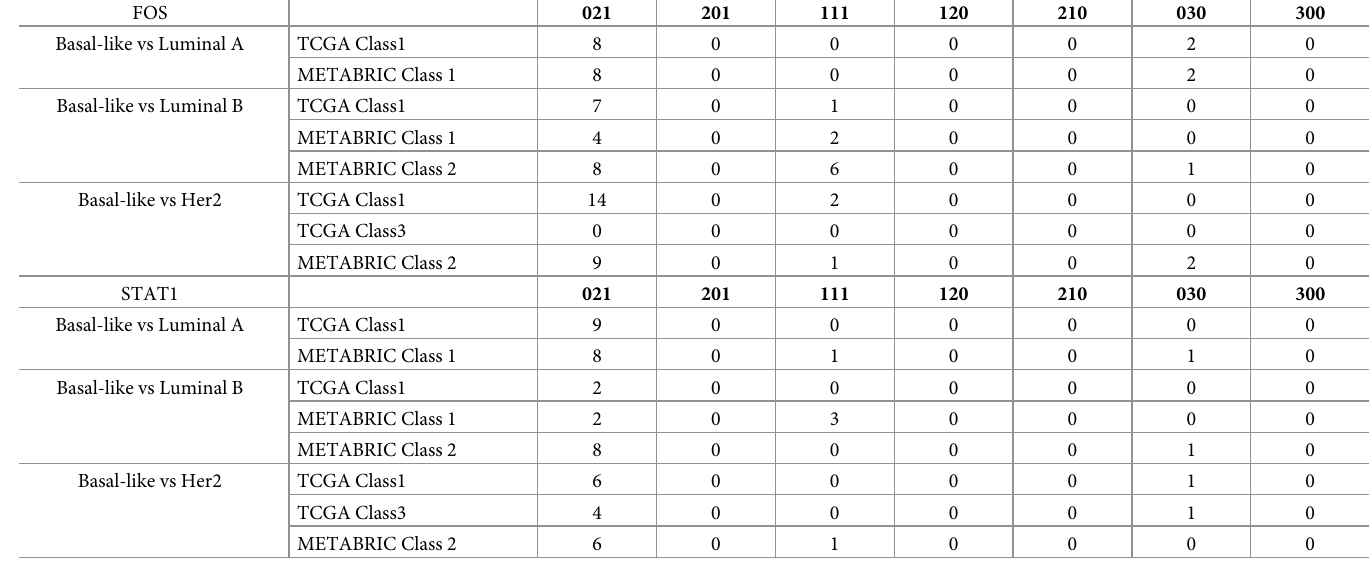
Table 2. Occurrence of the 7 types of NPU motifs centred around FOS and STAT1 from Basal-specific networks. Numbers in the table indicate the frequency of each NPU motif occurring in the corresponding hub-associated local networks. FOS